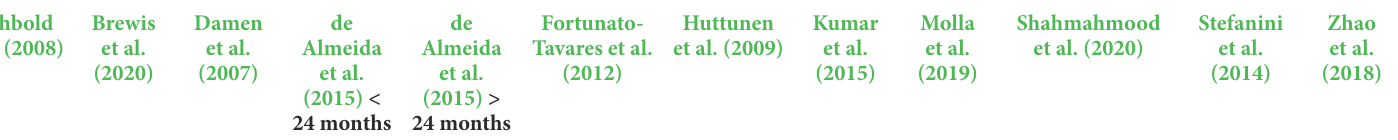
TABLE 6 Well-being subscale Tukey HSD post-hoc mean